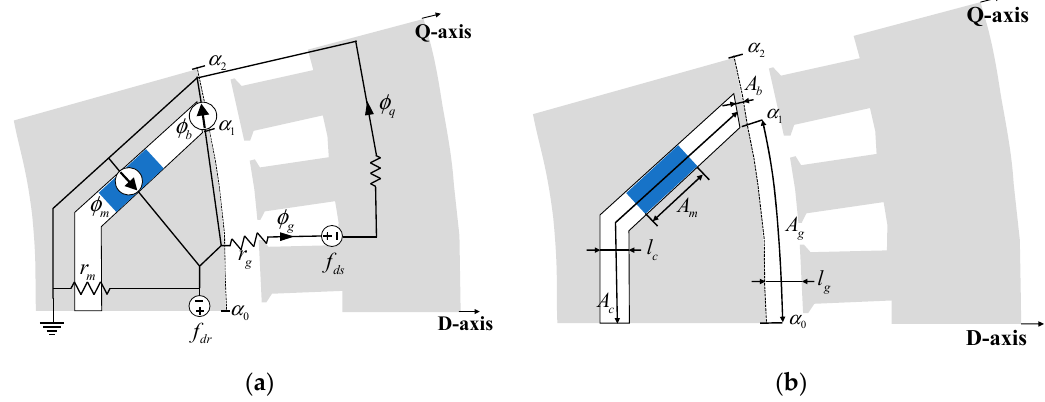
Figure 1. Magnetic equivalent circuit (MEC) for d-axis permanent magnet (PM) flux linkage ( a ) d-axis linear MEC for PM flux linkage. ( b ) Geometric definition for reluctances.